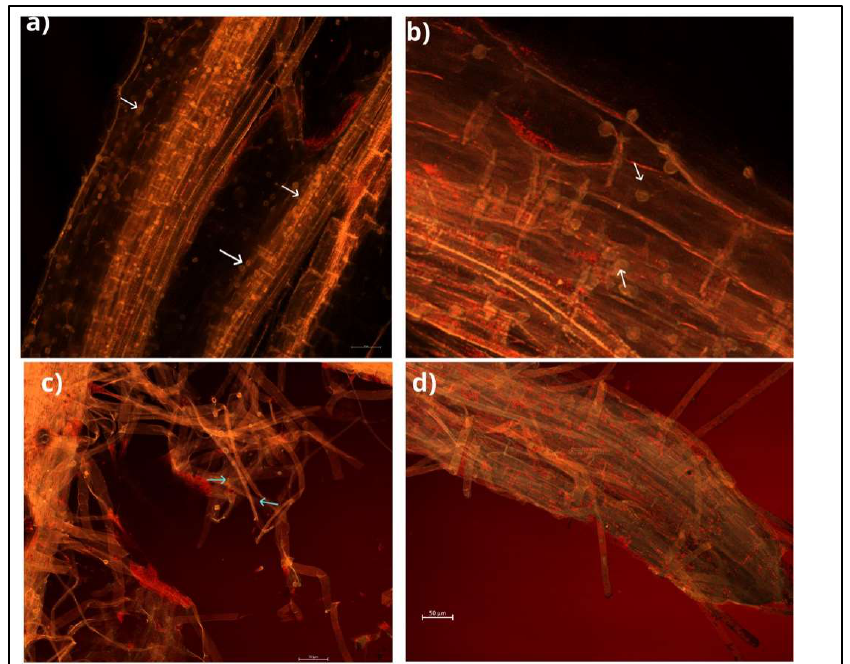
Figure 2. The roots of cabbage inoculated with S. indica observed under a fluorescent microscope; scale bars of 50 µm. ( a ) The cortex of cabbage roots covered with spores. ( b ) Close view of spores covering cabbage roots. ( c ) The fungal mycelium developing externally. ( d ) The fungus covering the root tip. White and blue arrows point to spores and mycelium, respectively.